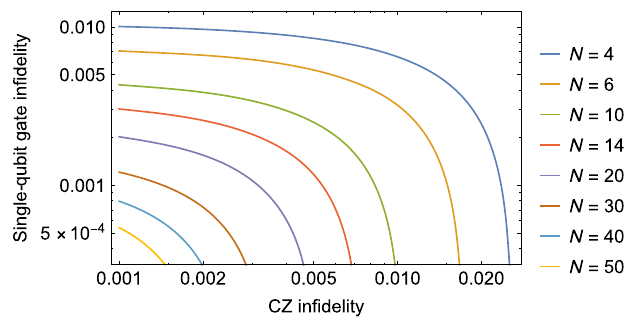
FIG. 9. The single-qubit gate and two-qubit CZ-gate infidelities needed to create a RGS of size N with 90% fidelity. The fidelity of the RGS is given by CZ N U 2 N þ 2 P 2 N , where CZ, U , and P are the fidelities of the CZ gates, single-qubit gates on the emitters and ancillas, and pumping operations,